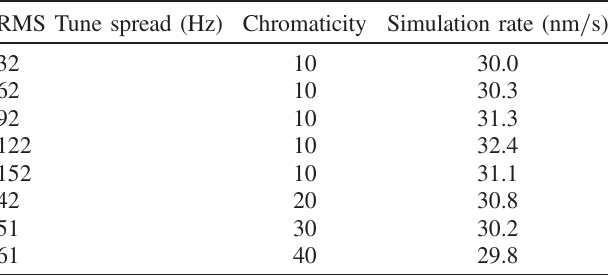
TABLE III. Simulated normalized transverse emittance growth rates with tune distribution. RMS tune changed by appropriate adjustment of octupole current and chromaticity. White noise with 1 . 4 × 10 − 6 rad 2 total power.